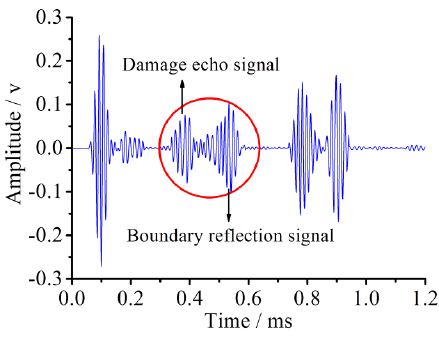
Figure 18. Sensor voltage signal for the pipe with 90° circumferential damage in the simulation.